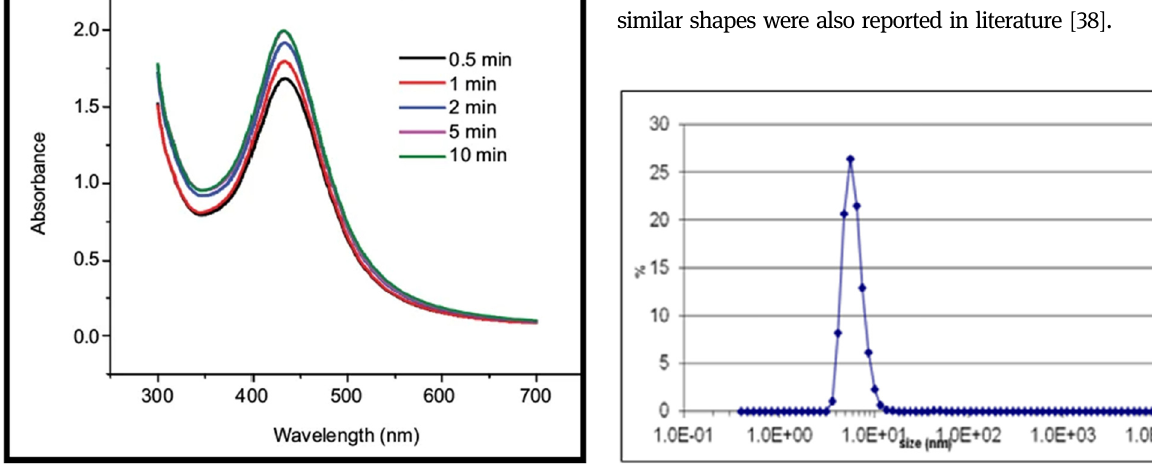
Figure 2: UV - Vis spectrum of AgNPs with time. Figure 3: Zeta analysis of green - synthesized